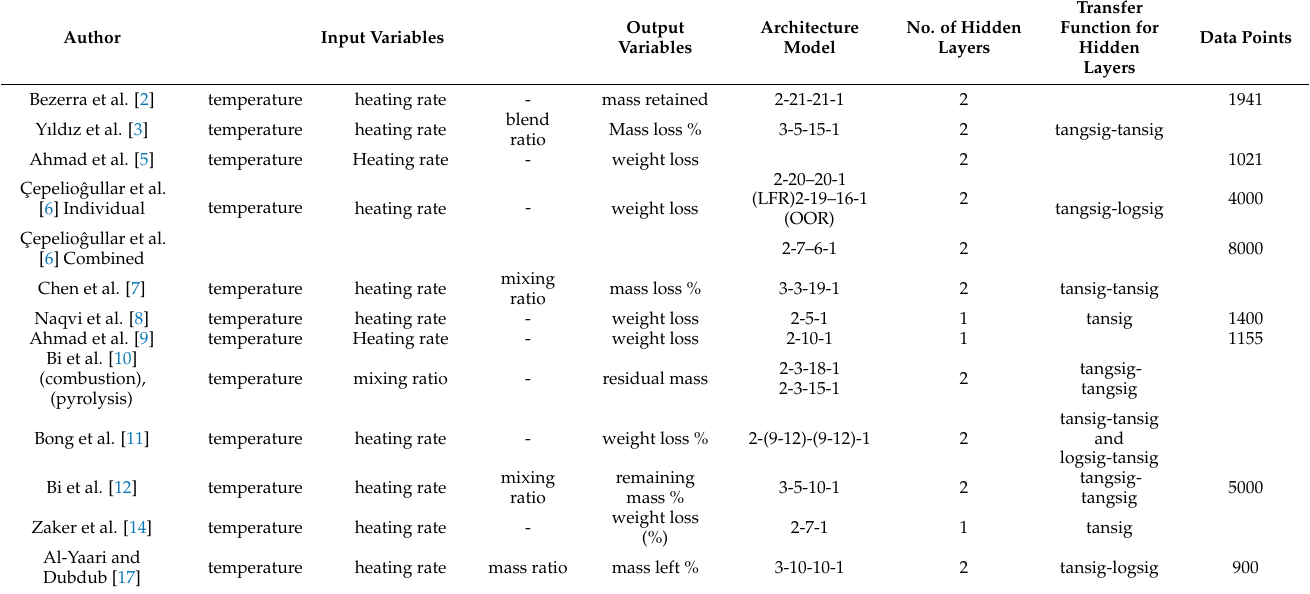
Table 1. Literature summary of ANN applications for non-isothermal TGA